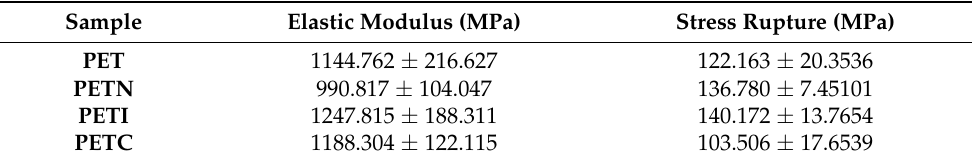
Table 3. Mechanical properties of PET films in the grafting process.